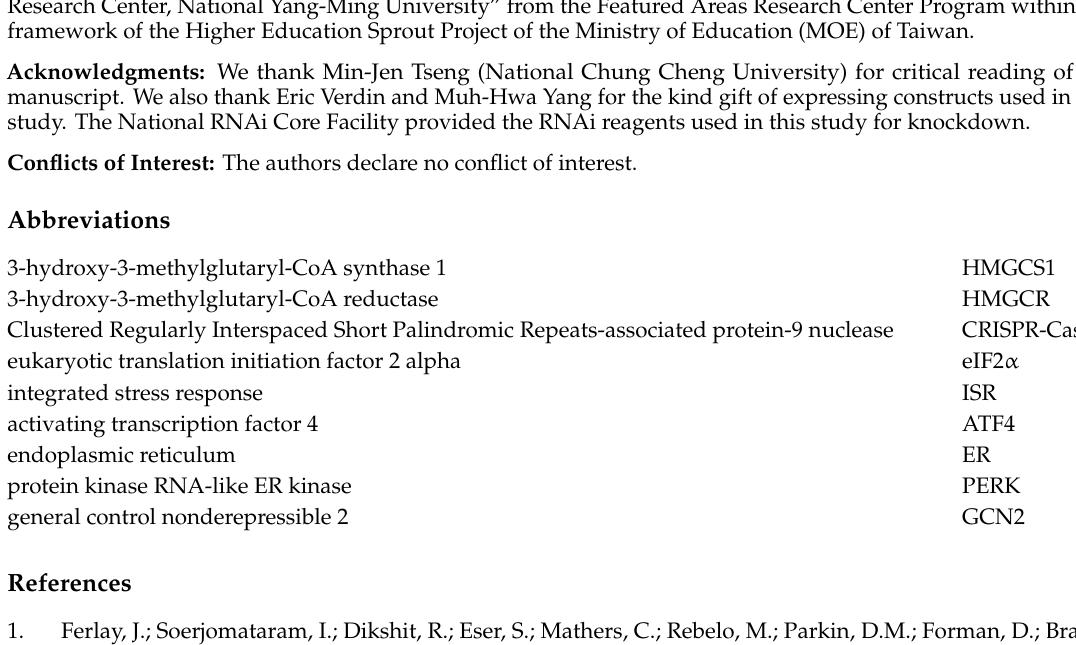
Figure S1: Expressions of HMGCS1 mRNA are increased in stomach adenocarcinoma specimens from patients with advanced stages of gastric cancer. Figure S2: HMGCS1 knockdown downregulates levels of pluripotency genes Oct4 and SOX-2 and suppresses progression in gastric cancer cells. Figure S3: Schematic diagram of CRISPR-Cas9-mediated HMGCS1 knockout showing sequences of the sgRNA and protospacer adjacent motif (PAM) in wild-type AGS cells as well as those of indels in knockout cells. Figure S4: HMGCS1 knockout suppresses mevalonate-promoted ability of cell growth in AGS cells. Figure S5: Co-treatment with lovastatin and dipyridamole blocks mevalonate pathway in gastric cancer cells. Figure S6: The statin- or dipyridamole-suppressed tumorsphere formation in KATO III and NCI-N87 cells is partially restored after mevalonate treatment. Figure S7: The statin- or dipyridamole-mediated decline in cell growth or tumorsphere formation is further deteriorated in NCI-N87 cells with HMGCS1 knockdown and AGS cells with HMGCS1 knockout. Figure S8: HMGCS1 is present in both nuclei and cytoplasms of gastric cancer tissues from patients. Figure S9: HMGCS1 enhances mRNA expression of ER stress markers in NCI-N87 cells. Figure S10: HMGCS1 knockdown inhibits a tunicamycin-mediated increase in the growth and progression of NCI-N87 cells under mild ER stress. Figure S11: A longer tunicamycin treatment suppresses the growth and progression of AGS cells with and without HMGCS1 knockdown. Table S1: Sequences of primers for siRNA, knockout, PCR, and real-time